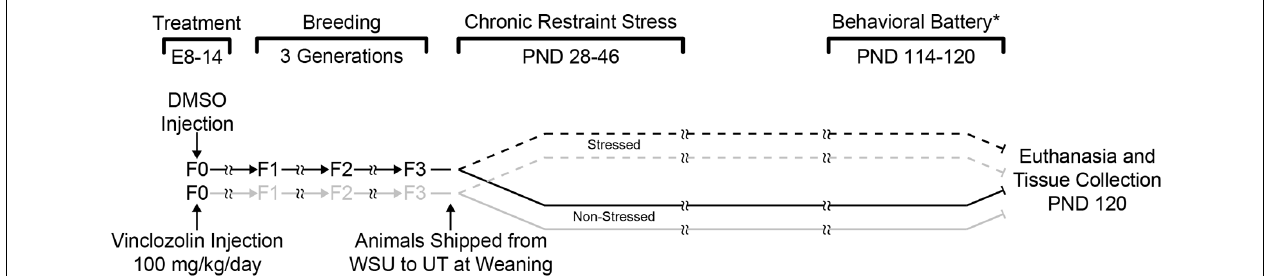
FIGURE 1 | Experimental design and timeline. F0 pregnant dams were injected daily with either DMSO or vinclozolin from E8 to E14. Pups were then breed within lineage until the F3 generation. F3 pups were shipped to the University of Texas after weaning. One control lineage (DMSO) and one vinclozolin lineage male was pair housed